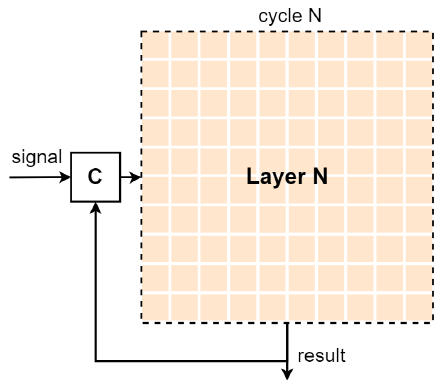
Figure 10. RCE in intergal